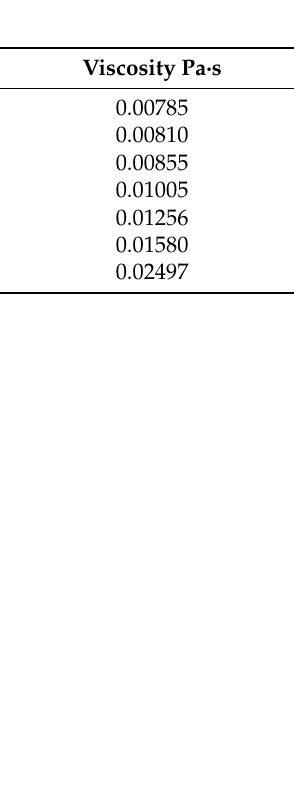
Figure 7. Storage and loss moduli of the waxy crude oil varying with